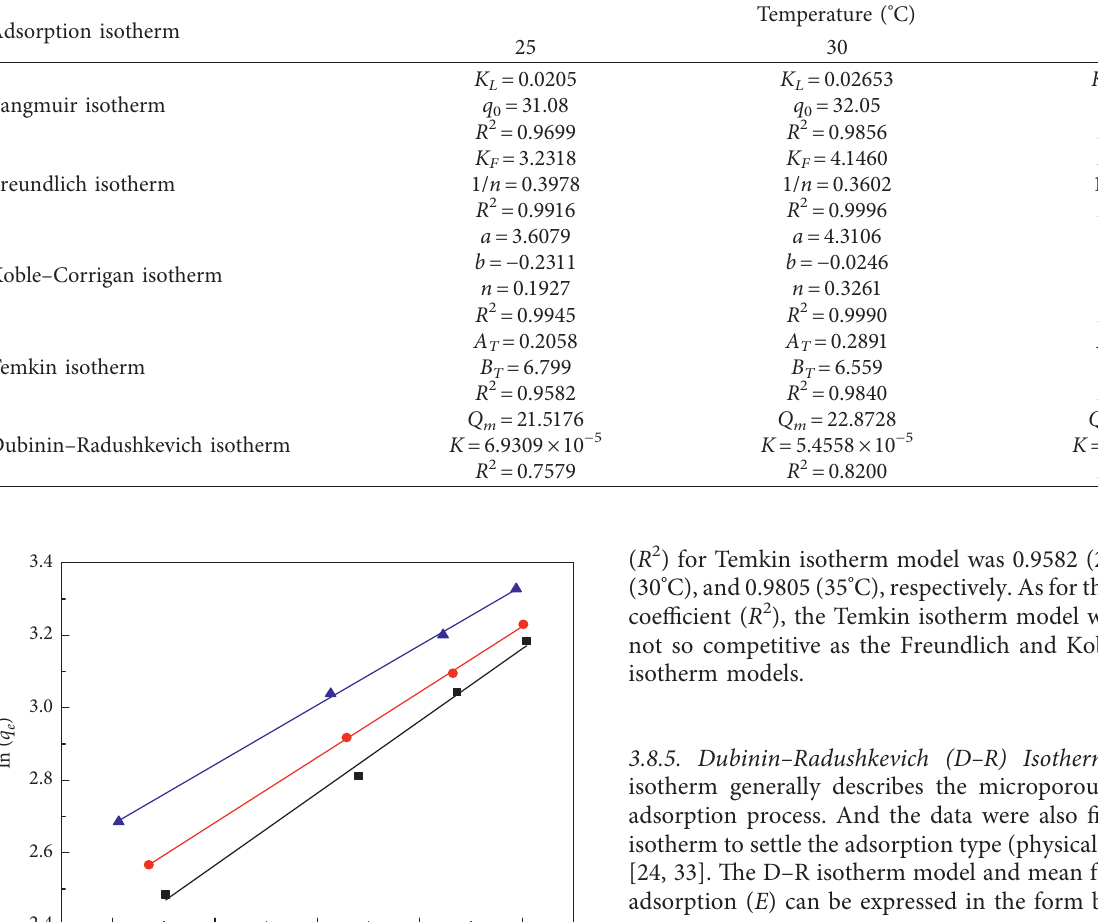
Table 2: Isotherm constants and regression data of adsorption isotherms of ammonium on EMRZ at different temperatures (EMRZ